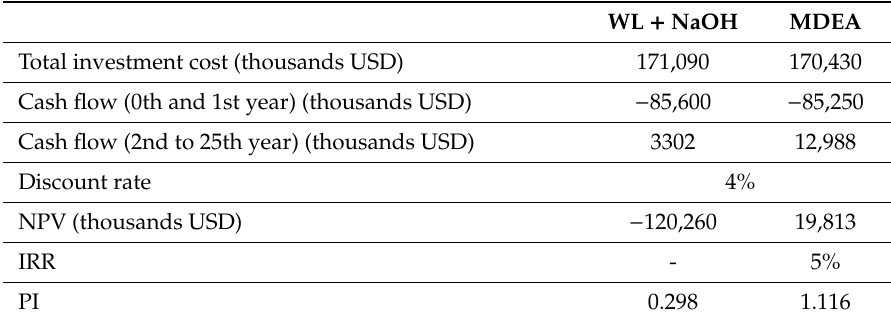
Table 16. Economic evaluation for the whole plant. IRR = internal rate of return, NPV = net present value, PI = profitability index.